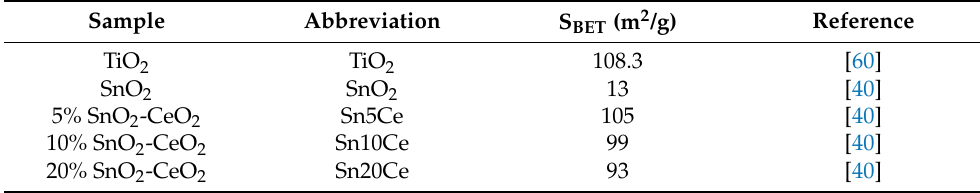
Table 3. Surface area of the investigated sensitive powder-type samples.